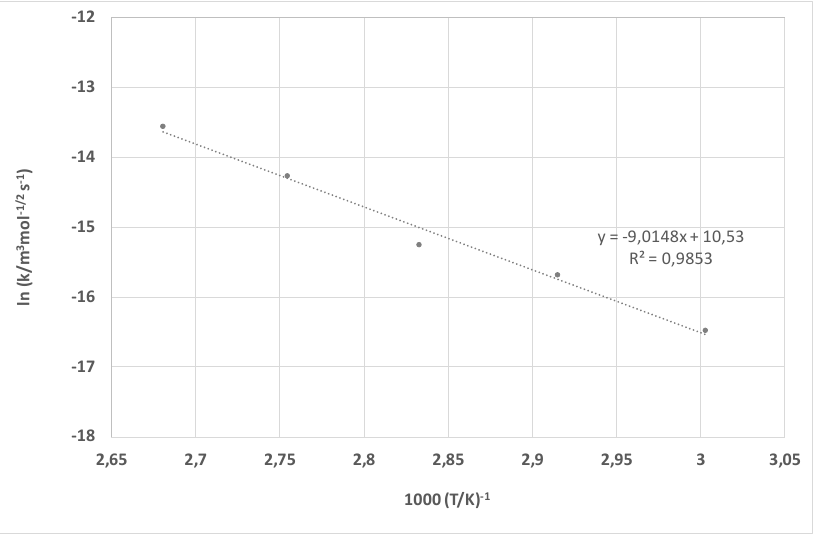
Figure 10. The Arrhenius plot for experiments in the 1.5 mol cm − 3 NaOH solution in the presence of HDTMAC.